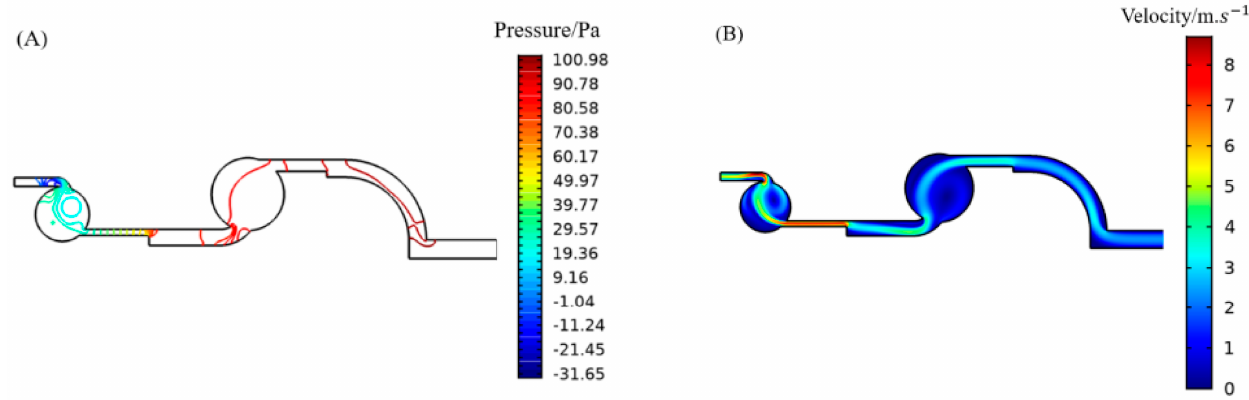
Figure 4. Microfluidic chip simulation diagram: ( A ) microfluidic chip pressure map; ( B ) microfluidic chip velocity